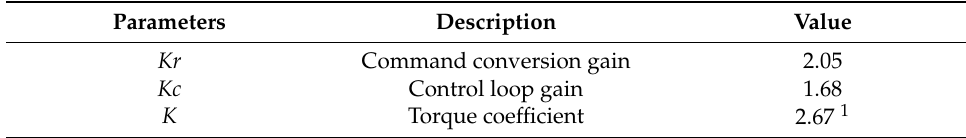
Figure 8. Block diagram of the force-free control. Table 5. Gain parameters of the force-free control.